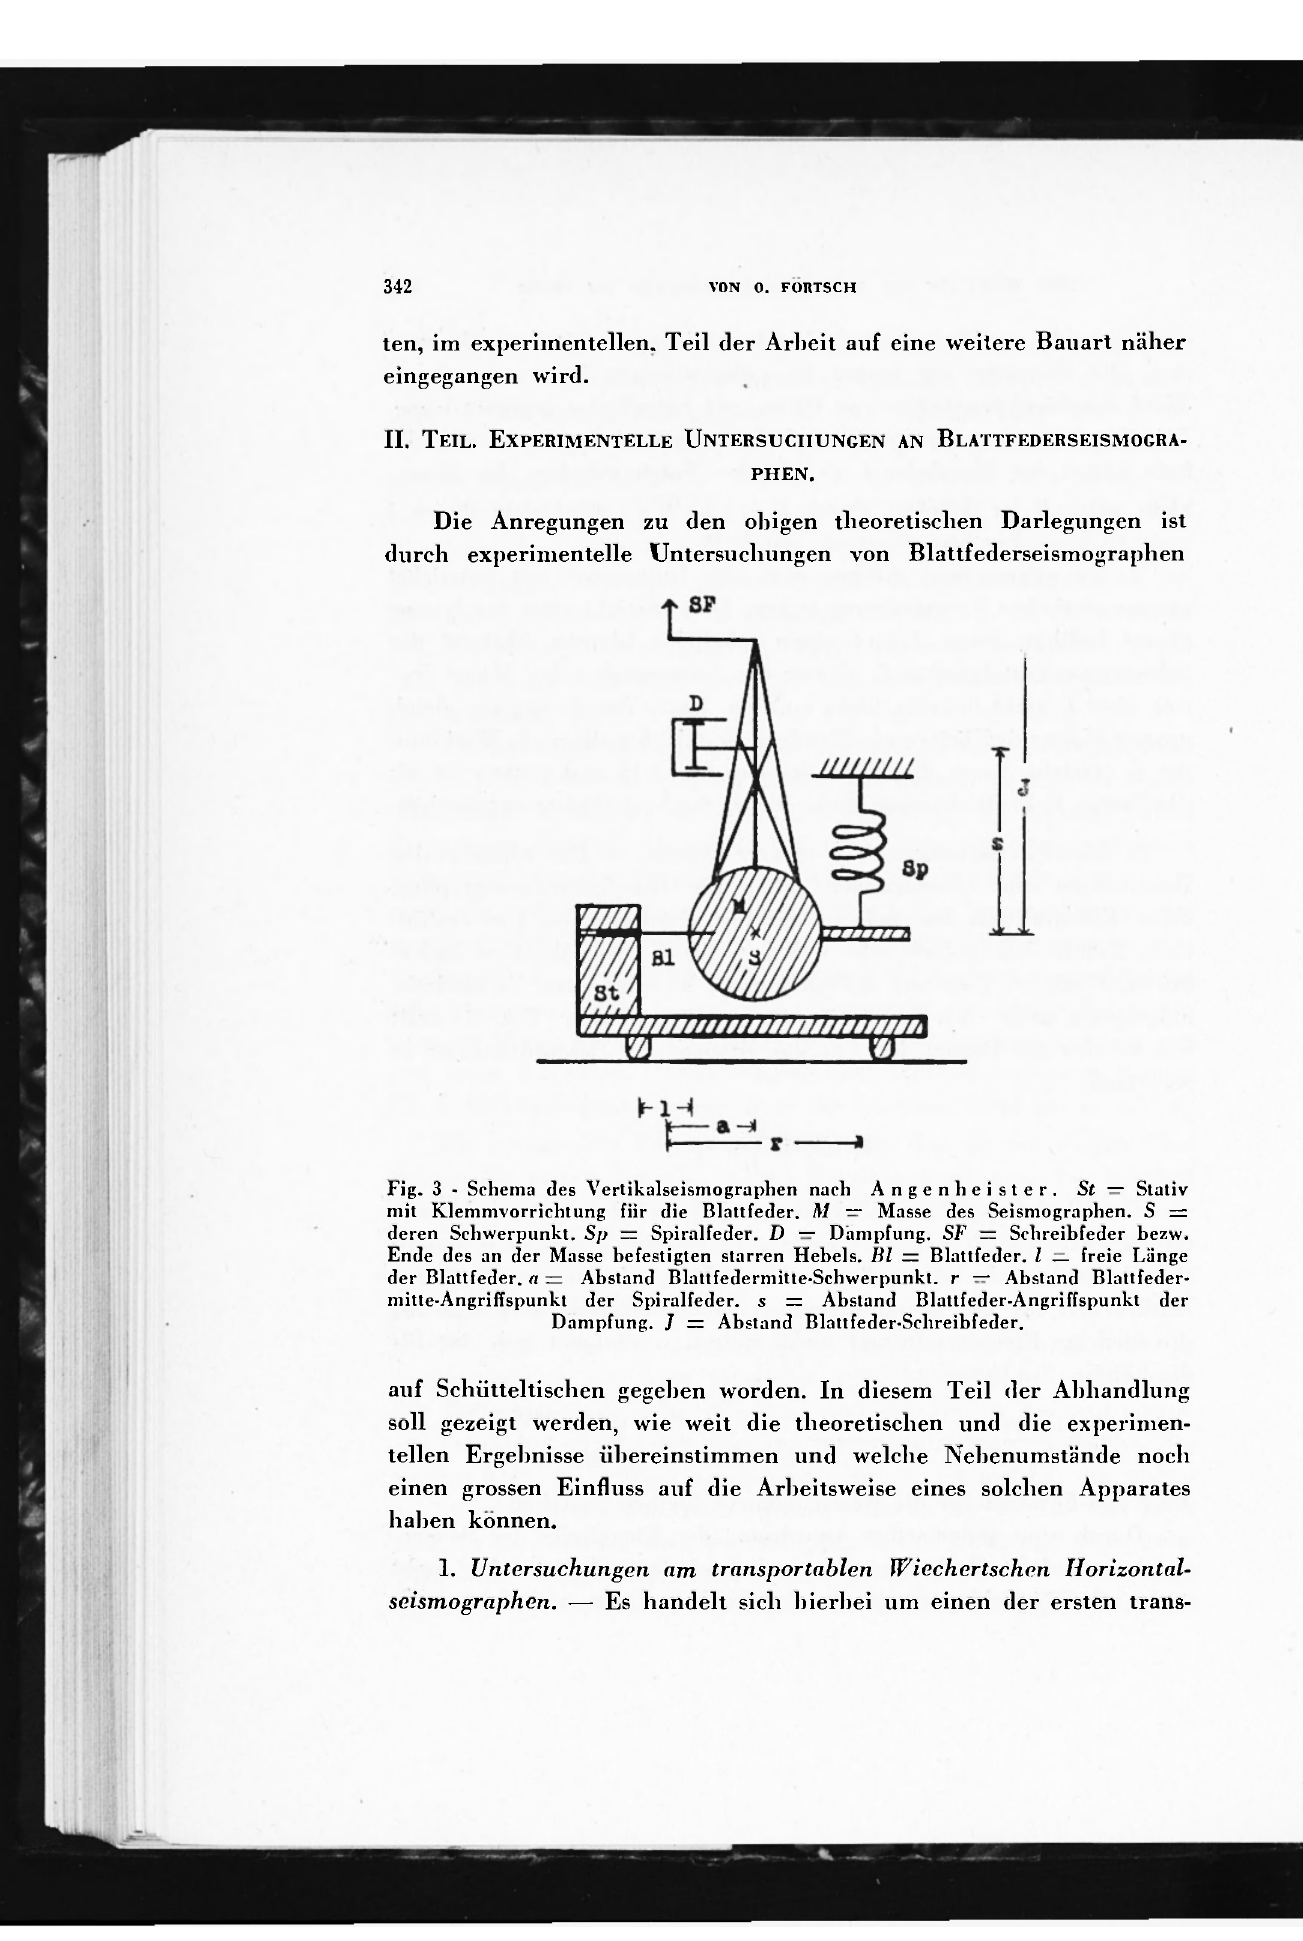
Fig. 3 - Schema des Vertikalseismographen nach A n g e n h e i s t e r. St — Stativ mit Klemmvorrichtung fiir die Blattfeder. M — Masse des Seismographen. S = deren Schwerpunkt. Sp = Spiralfeder. D — Dampfung. SF = Schreibfeder bezw. Ende des an der Masse befestigten starren Hebels. Bl = Blattfeder. I — freie Liinge der Blattfeder. a = Abstand Blattfedermitte-Schwerpunkt. r — Abstand Blattfeder- mitte-Angriffspunkt der Spiralfeder. s = Abstand Blattfeder-Angriffspunkt der Dampfung. J = Abstand